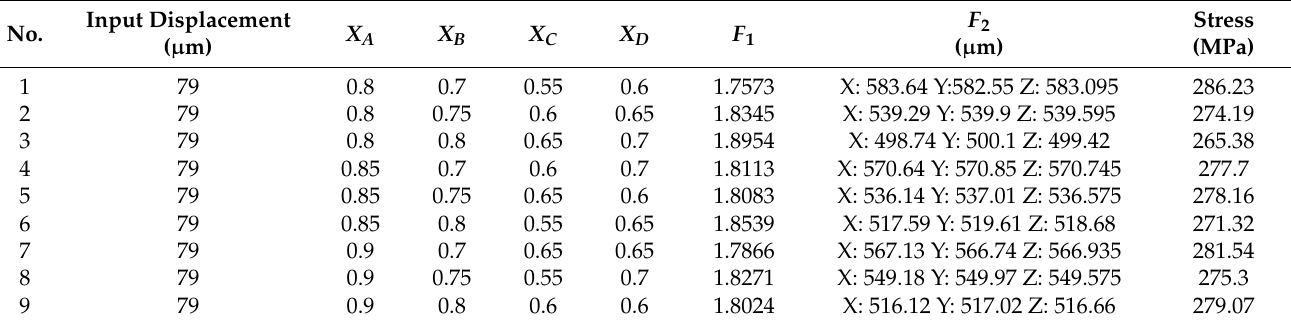
Table 4. Numerical results (Input displacement of 79 µ m).